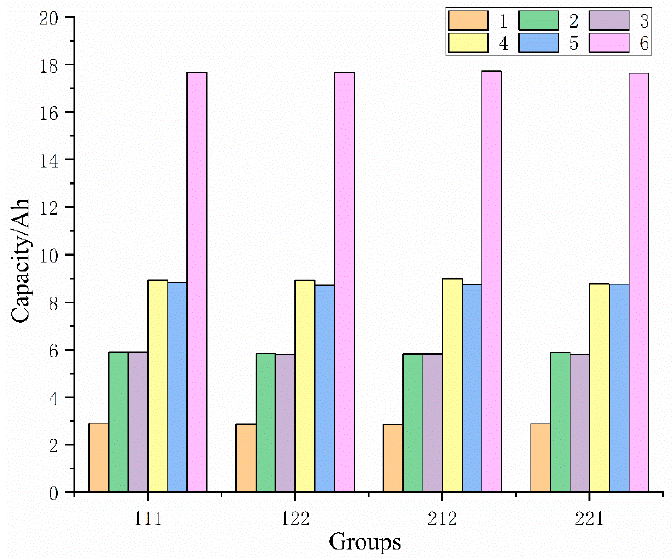
Figure 13. Battery pack capacity of different topologies and different experimental groups.